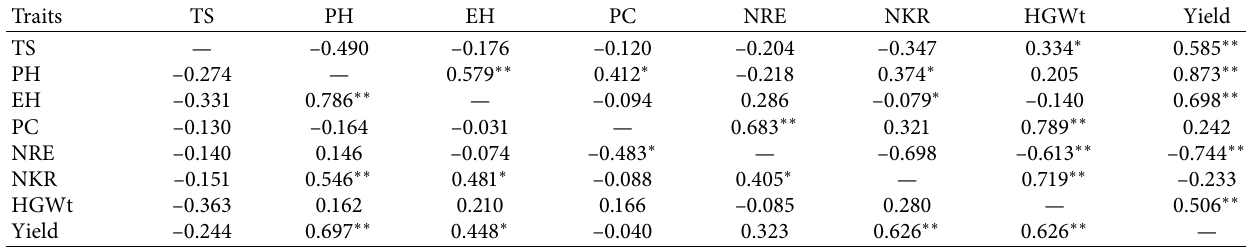
Table 3: Genotypic and phenotypic correlation coefficients among the traits.